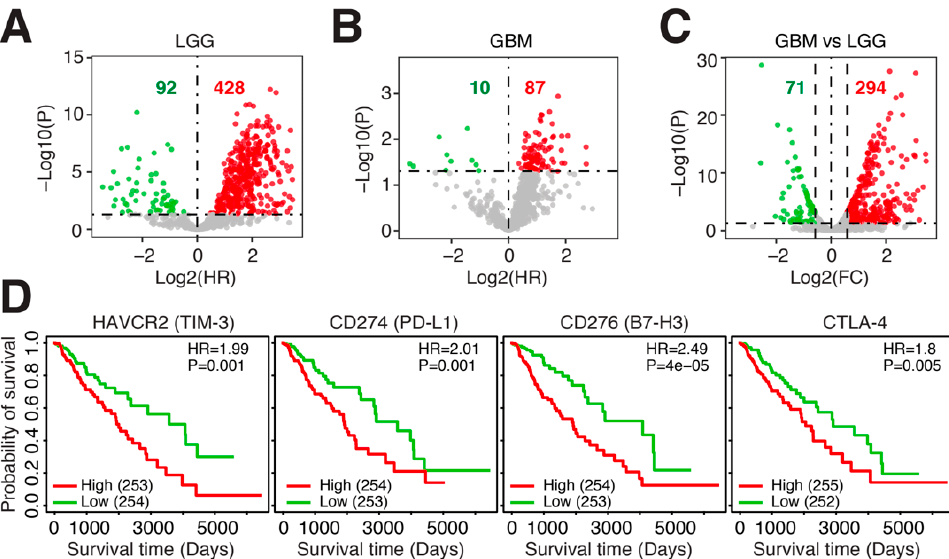
Figure 1. Immune-related genes (IRGs) are negatively associated with prognosis in glioma. Log2 hazard ratio of univariate Cox regression models evaluating the association between overall survival and IRG expression in ( A ). TCGA-LGG (n = 515) and ( B ). TCGA-GBM (n = 160). ( C ). Log2 fold change between IRG expression in TCGA-LGG (n = 515) and TCGA-GBM (n = 160). ( D ). Kaplan–Meier plots of four immune checkpoint genes in TCGA-LGG (n = 515). HR = hazard ratio. p = log-rank p -value.